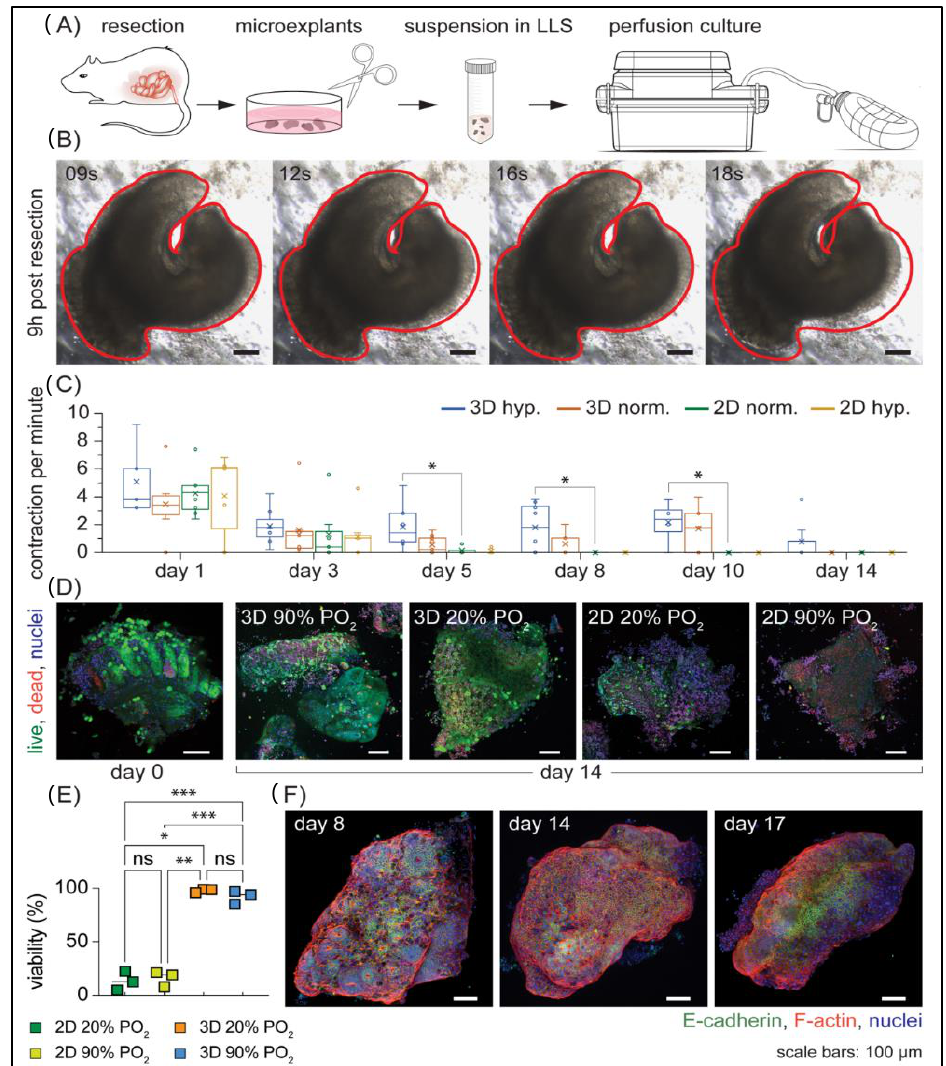
Figure 3. Ex vivo culture of microexplants: ( A ) Diagram outlining major steps of mouse colorectal microtissue fabrication and culture in perfusion platform. ( B ) A series of time-lapse microscopy images showing the periodic contraction of a representative mouse colorectal microexplant from collected samples ( n = 20) that had been cultured under perfusion for 9 h. Contraction frequency was estimated to be 3 contractions per minute (cpm) and was recorded at 1 fps for 10 min. ( C ) Assessment of microexplant contractility (4 ≤ n ≤ 9 per condition, * = p < 0.05) under 4 culture conditions: 3D hyperoxic (90% PO 2 ) and normoxic (20% PO 2 ), and 2D hyperoxic (90% PO 2 ) and normoxic (20% PO 2 ). Measurements were compared to the 2D 20% PO 2 to determine significance. ( D ) Micrographs of the viability of microexplants by fluorescent microscopy using Calcein AM (live) and BOBO-3 Iodide (dead). ( E ) Quantification of D ( n = 3 per condition, * = p < 0.05, ** = p < 0.01, and *** = p < 0.001). ( F ) Representative microexplants from the 3D hyperoxic condition at days 8, 14, and 17, stained with Hoechst 33342 (nuclei), Alexa Fluor™ 568 Phalloidin (F-actin), and E-cadherin (epithelial cells), demonstrate the well-preserved heterogenous microexplant structure. Data in Figure 3 were collected from three separate mice and are representative of 5 experiments using 7 mice in total. Table 1. Summary of existing gut explant culture platforms and culture conditions.